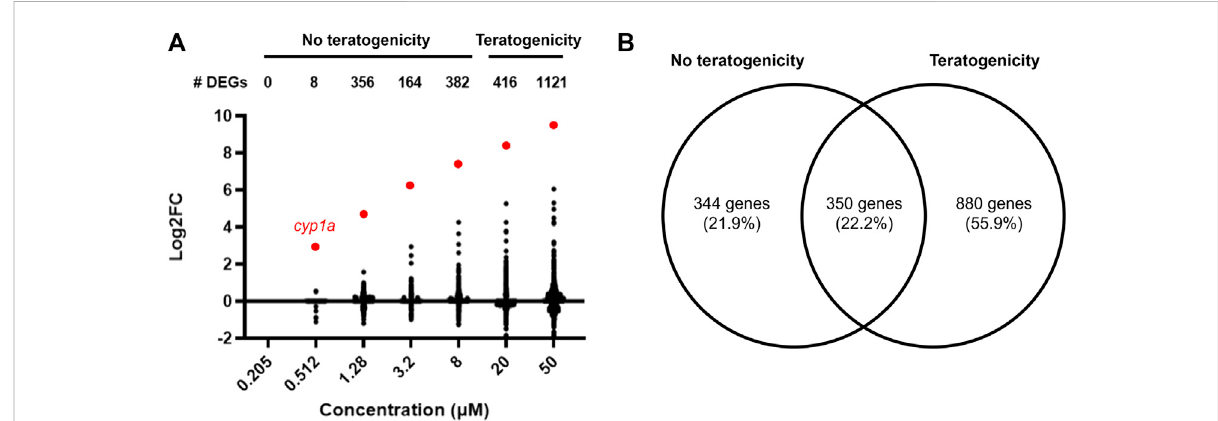
FIGURE 3 (A) Number of differentially expressed genes and their corresponding Log2 fold change values at each retene concentration (adj. p < 0.05). Cyp1a is highlighted red. (B) Venn diagram of DEGs at concentrations with and without teratogenicity at 120 hpf. Overlapping region represents genes which were differentially expressed in at least one non-teratogenic and one teratogenic